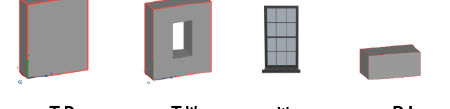
Figure 6. Basic shape vocabulary elements {S} for